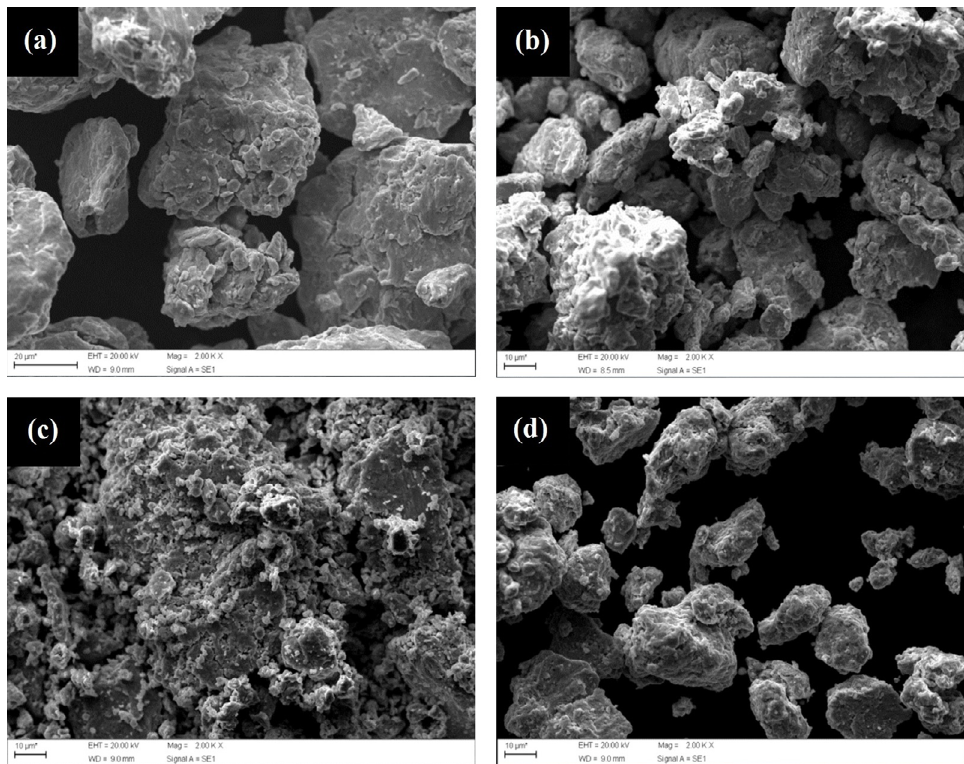
Figure 2. SEM of the AISI 52100 steel milled through 10 hours with (a) 0% of alumina (b) 1% of alumina (c) 3% of alumina (d) 5% of alumina